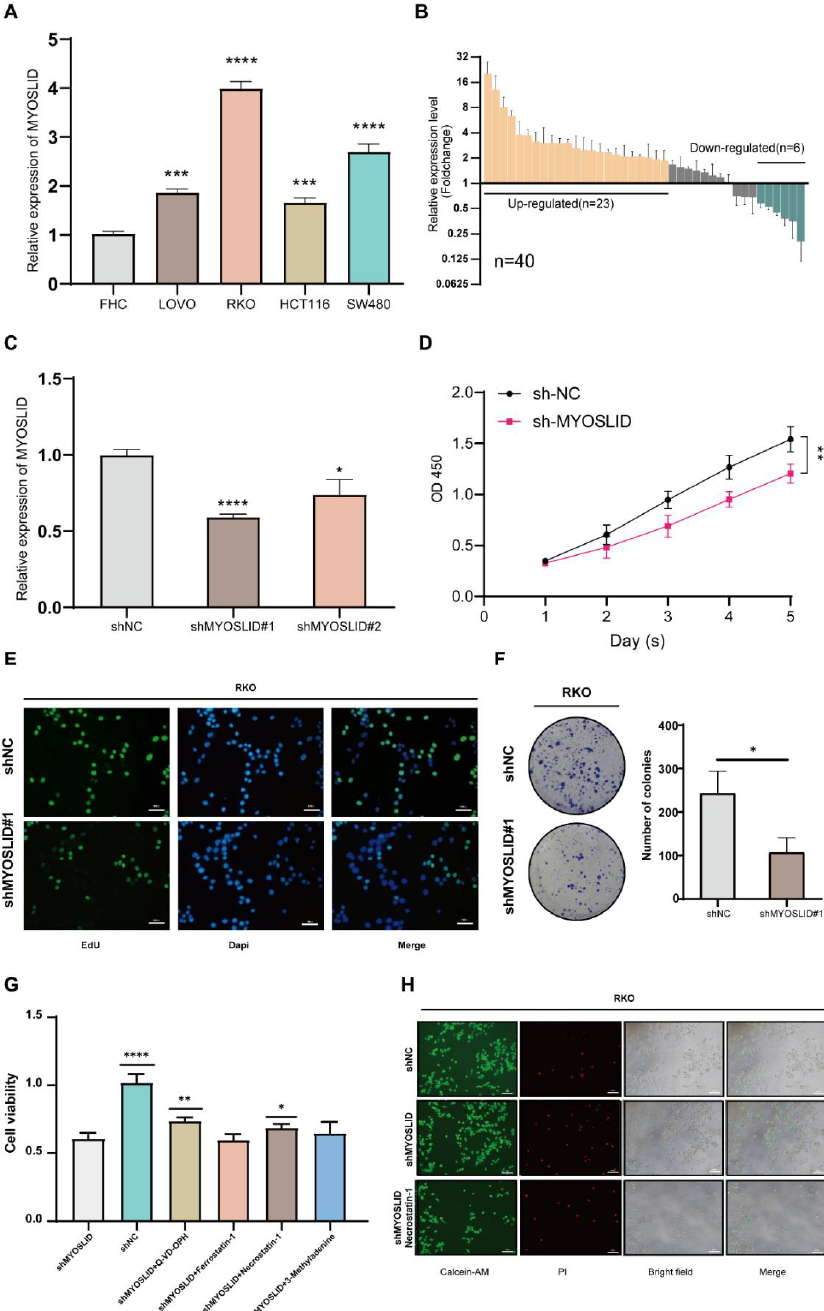
Figure 10. The LncRNA MYOSLID promotes the proliferation of CRC by regulating necroptosis. ( A ) A bar chart showing the expression level of MYOSLID in human normal colon epithelial cells (FHC) and four human CRC cell lines (LOVO, RKO, HCT116, SW480). ( B ) The expression level of MYOSLID in paired colorectal cancer samples. ( C ) The expression level of MYOSLID after knockdown by short hairpin RNA. ( D ) Cell proliferation was measured using CCK-8 assays in RKO cells. ( E ) Evaluation of cell proliferation in MYOSLID knockdown RKO cells by EdU assays. ( F ) Evaluation of the colony formation capacity in MYOSLID knockdown RKO cells. ( G ) The cell viability of the RKO wild-type group and the shMYOSLID stably transfected group after treatment with the blank control, Q-VD- OPH, necrostatin-1, ferrostatin-1 and 3-methyladenine. ( H ) The fluorescence intensity excited by Calcein-AM/PI indicated the viability of RKO cells after treatment with necrostatin − 1. *: p < 0.05, **: p < 0.01, ***: p < 0.001, ****: p < 0.0001. ns: No